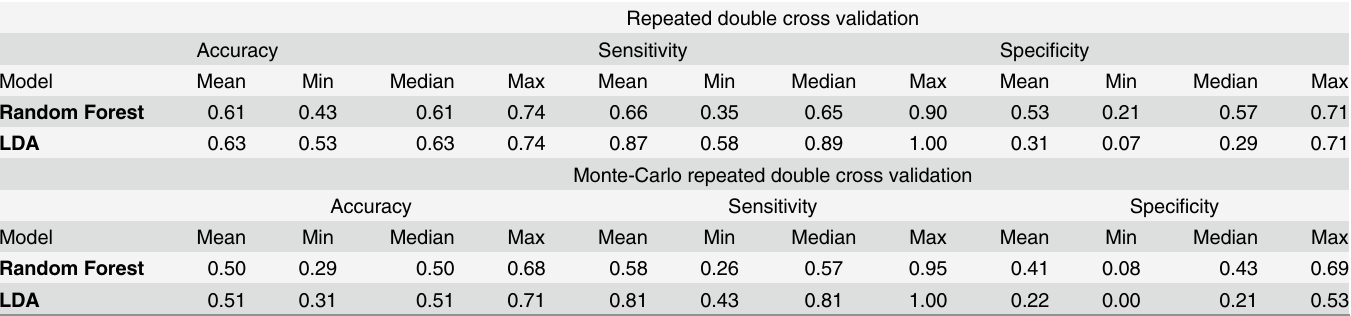
Table 4. Accuracy results of PSA testing for prostate cancer assessed using repeated double cross validation of Random Forest and Linear Dis- criminant Analysis (LDA) models.